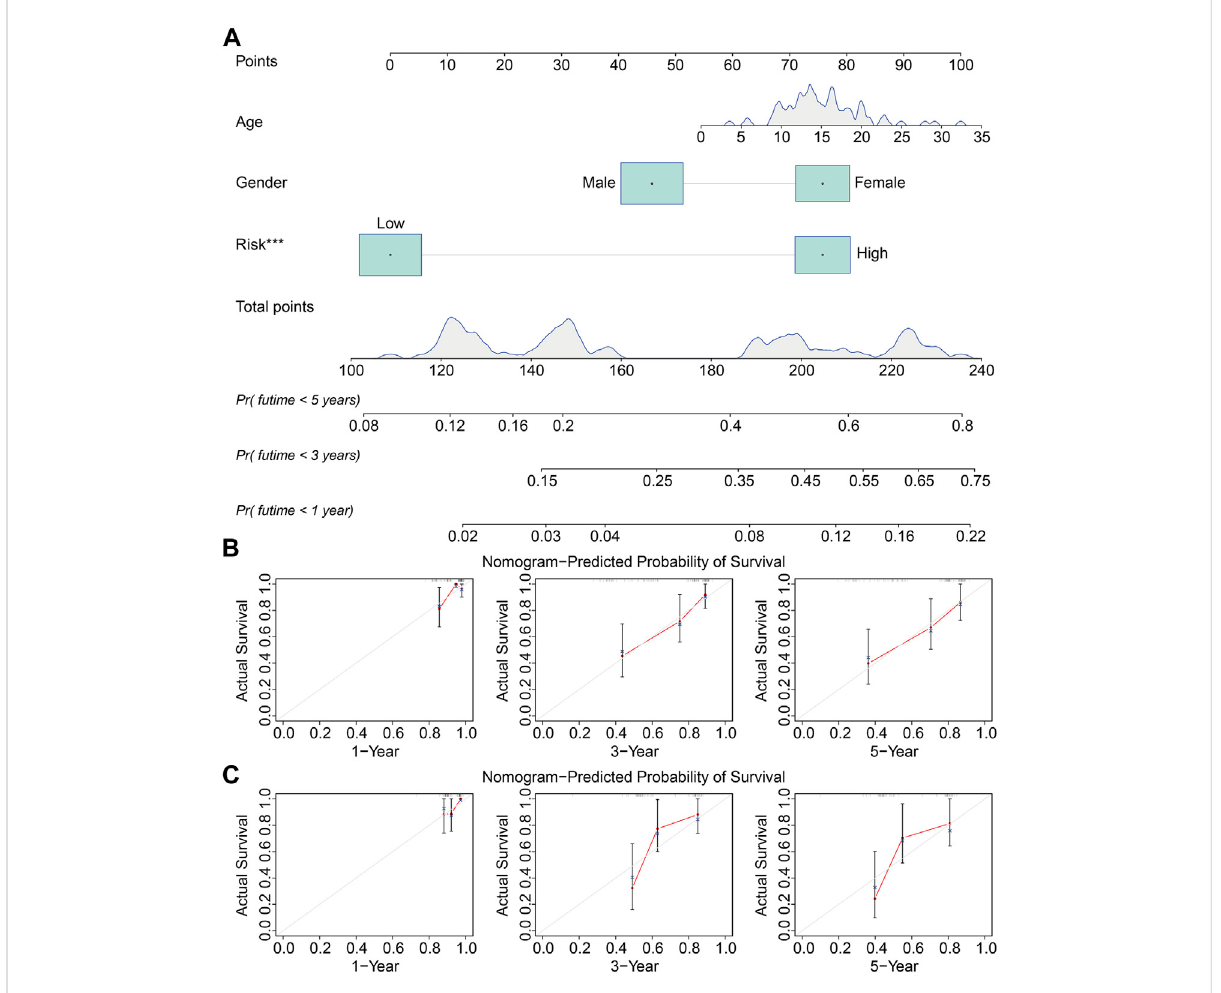
FIGURE 7 Construction of a prognostic nomogram for survival prediction. (A) Nomogram including gender, age, and signature-derived risk score for 1-, 3-, and 5-year overall survival rate prediction. (B,C) Calibration plot for predicting patients ’ survival at 1, 3, and 5 years in TCGA cohort (B) and the GSE21257 cohort (C)